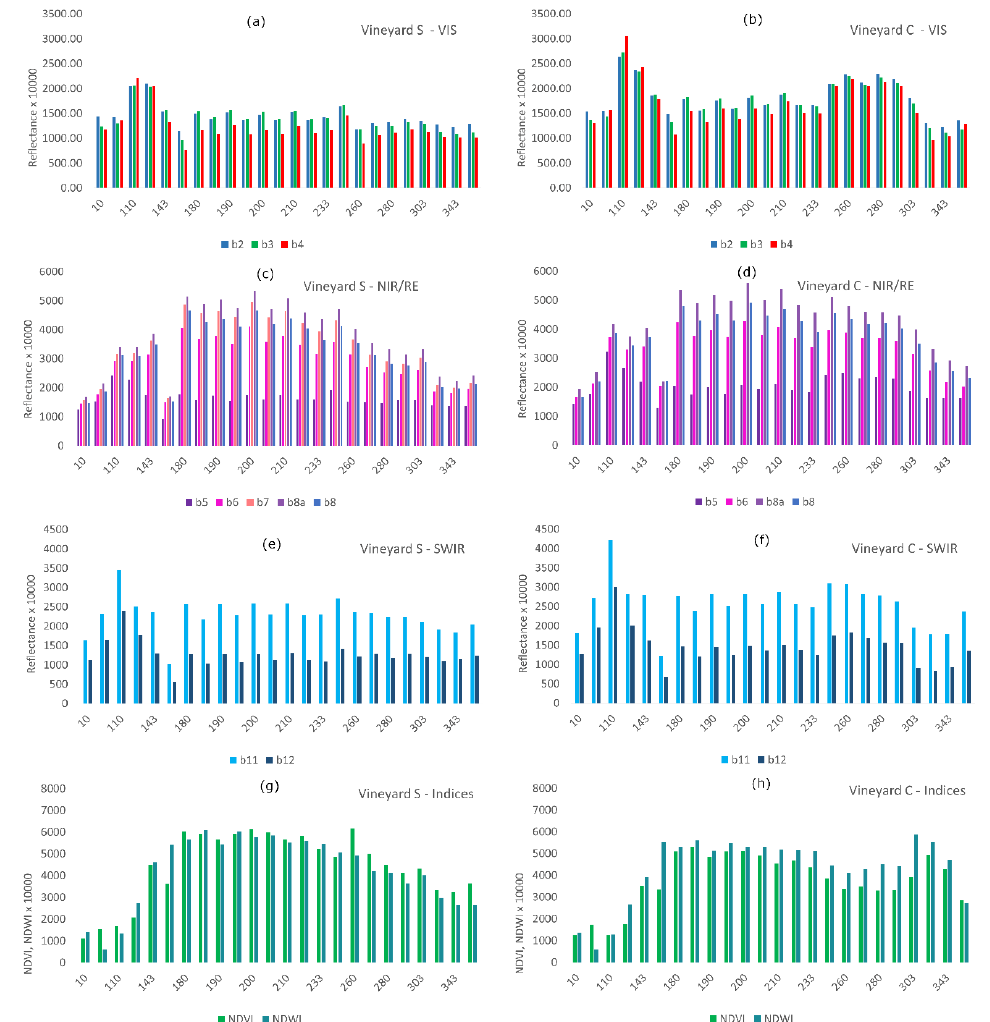
Figure 4. At-vineyard level averaged spectral response (reflectance and indices) of S and C covered vineyards along the year (2016). Values were computed at plot level for each date for all the considered S2 bands and for NDVI and NDWI indices. Spectral profiles of the two vineyards were quite similar. Figures ( a , c , e ) refer to vineyard S and show temporal trends of visible, NIR and SWIR bands, respectively. Similarly, figures ( b , d , f ) refer to vineyard C and show temporal trends of visible, NIR and SWIR bands, respectively. Figure ( g , h ) show temporal trends of spectral indices (NDVI, NDWI) for vineyard S and C respectively.